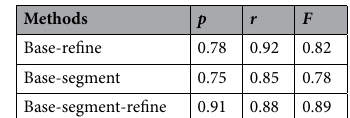
Table 1. Results of the ablation experiments for the